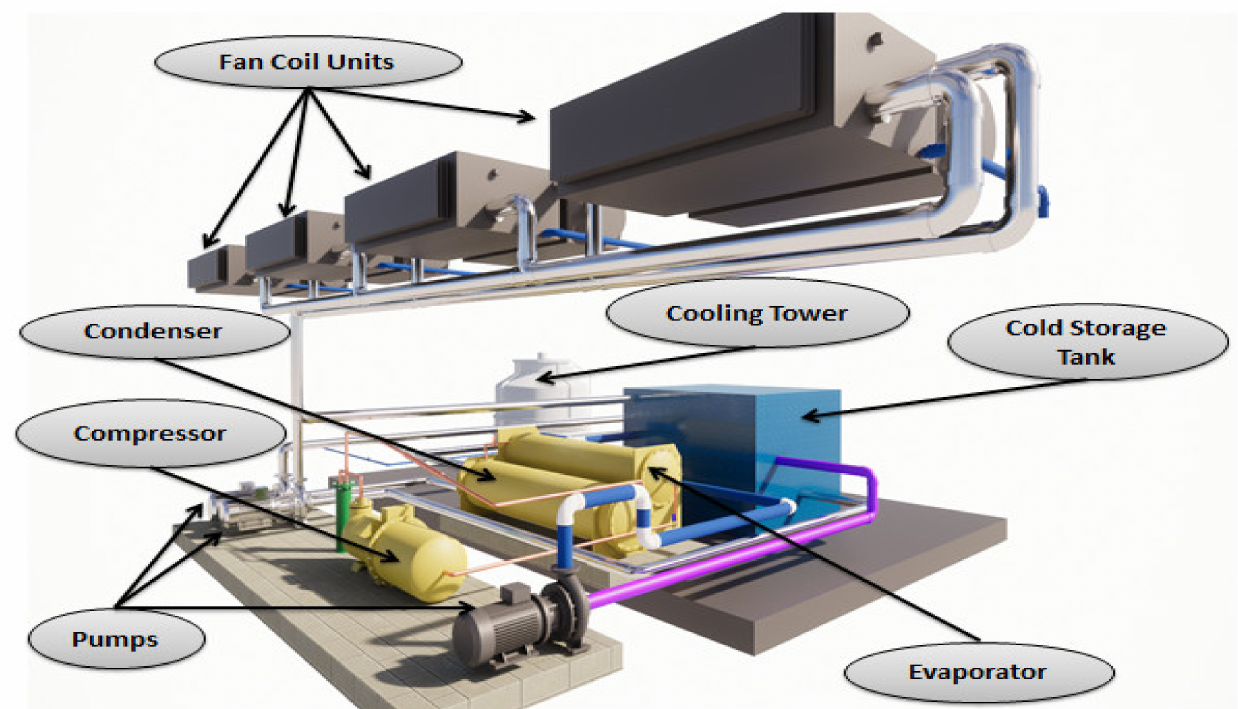
Figure 4. Schematic of the water chiller air-conditioning system combined with cold storage.